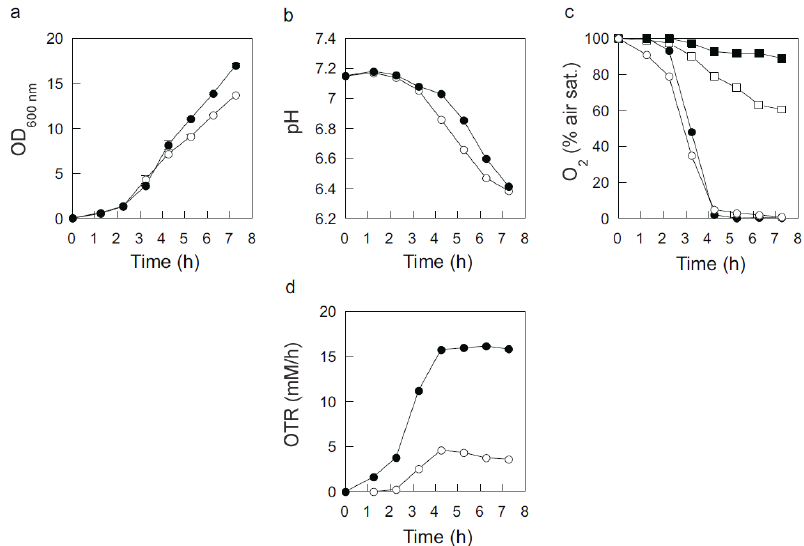
Figure 3. E. coli cultivation in different containers . The 100-mL cultures in 1-L Erlenmeyer flasks (open symbols) and 250-mL HT tubes (closed symbols) were incubated , ( b ) pH, and ( c ) c at 37 °C with agitation at 200 rpm. At the times indicated, the ( a ) OD 600 G (squares) and c (circles) were measured. The c and c were reported as % air sat. ( d ) The L G L OTR was calculated from Equation (1). This experiment was performed in duplicate; error bars represent